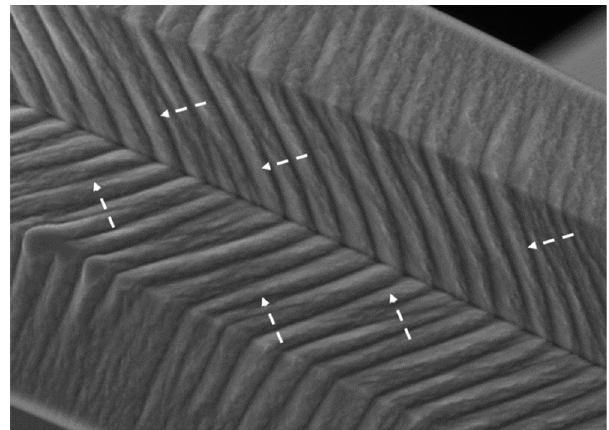
Figure 13. Machined chip SEM image of the V-shaped section. The dotted arrow indicates the flow direction of the chip.